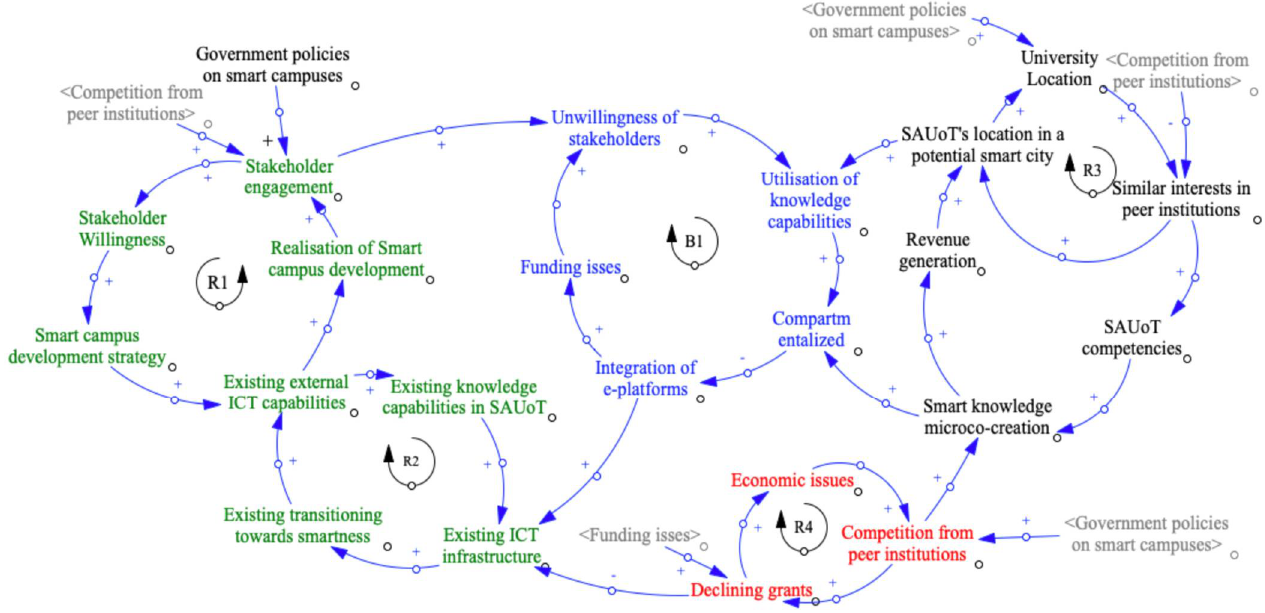
Figure 1. Initial SWOT causal loop diagram (green—strengths; black—opportunities; blue—weaknesses; red—threats) Source: Authors’ construct (2020).